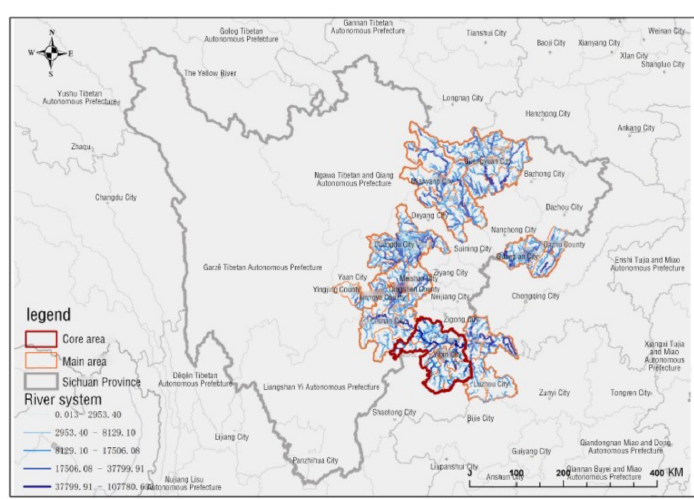
Figure 7. Hydrological analysis of research areas in Sichuan